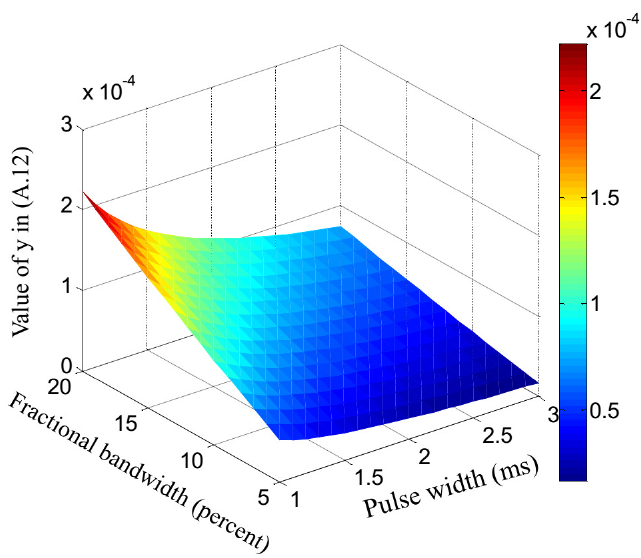
Figure A1. The value of y in Equation